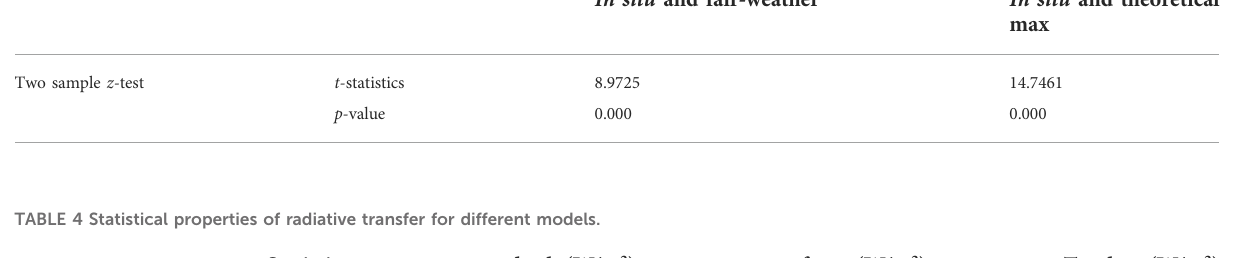
TABLE 3 z-test results.